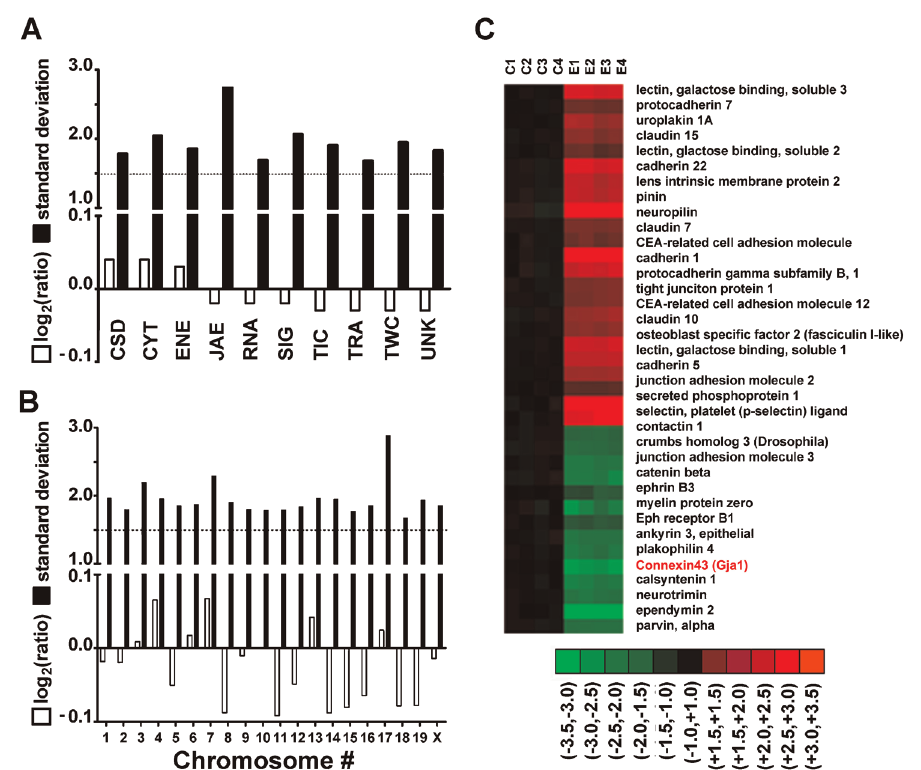
Figure 1. Expression regulation of gene cohorts in AT-EAE mouse spinal cord. A–B . Log 2 ratios (negative for down-regulation) and standard deviation of expression ratios of gene cohorts sharing the same molecular function ( A ) or chromosomal location ( B ). Note that while the average fold change was less than 1.5 for all cohorts, the standard deviation of the fold change exceeded 1.5. Highest standard deviations were obtained for JAE genes and for those located on chromosome 17. ( C ) Heatmap of the regulated JAE-J genes. C1–C4 ¼ logratios in the four controls, E1–E4 ¼ logratios in the four AT-EAE mice. All logratios were computed with respect to the average expression level in control mice. Red/green/black color indicates up/down/no regulation in the respective set. Note both the reproducibility (green, red, or black color for all four sets of the same condition) and the variability (non-uniform nuance of the color) of the gene expression patterns among the animals of the same